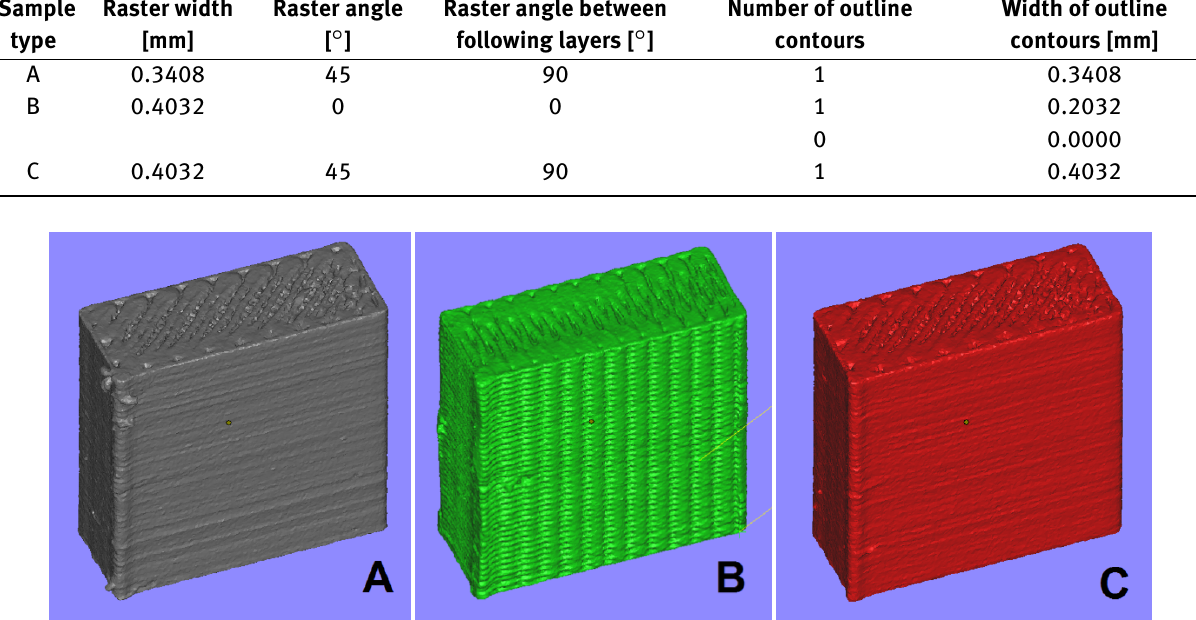
Figure 2: 3D scanned volume by Metrotom device from samples in STL format.